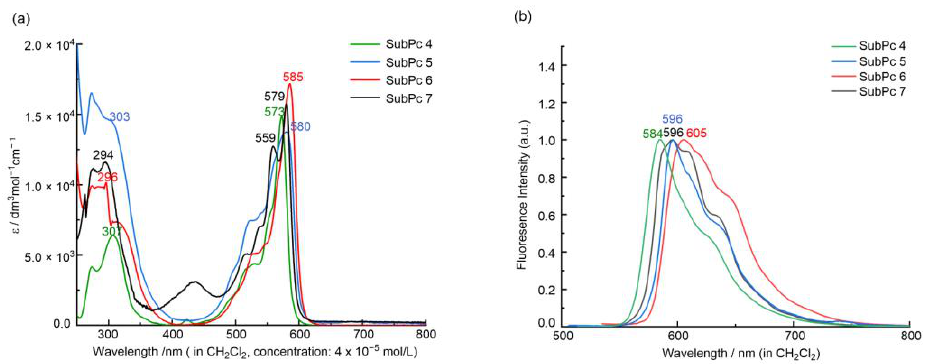
Figure 1. UV-Vis ( a ) and emission ( b ) spectra of 4 – 7 in CH 2 Cl 2